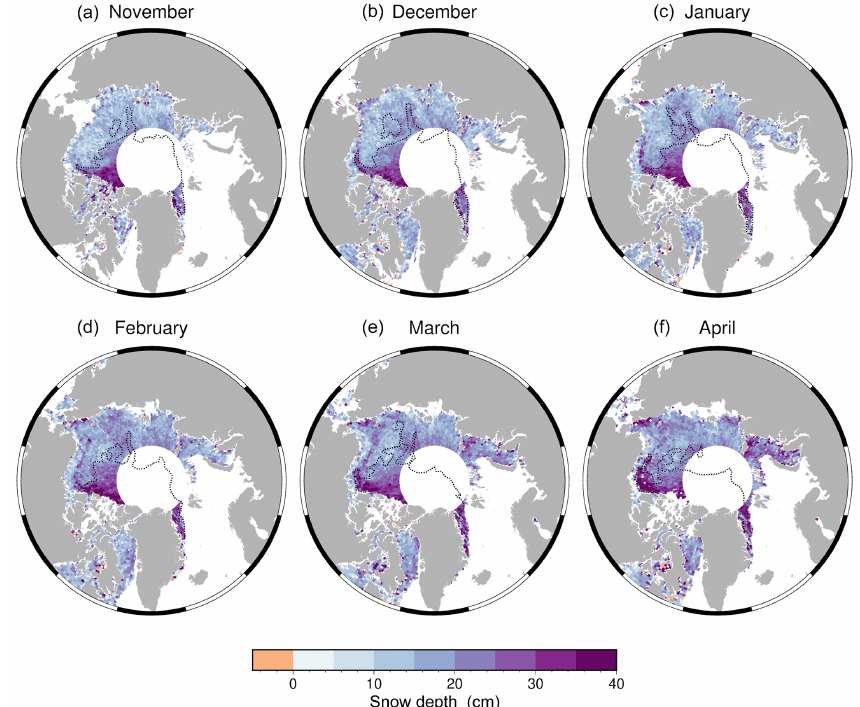
Figure 3. Monthly snow depths for the growth season November 2015 (a) to April 2016 (f) , derived from the AltiKa minus CS-2 calibrated freeboard. The multi-year ice boundary for each month is shown by the dashed black line, adapted from the OSI SAF Quicklook sea ice type map for the 15th day of the month, available at http://osisaf.met.no/p/osisaf_hlprod_qlook.php?prod=Ice-Type&area=NH (last access: 1 March